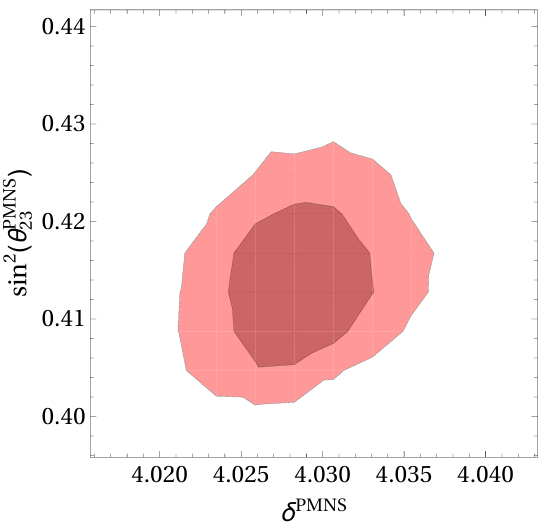
Figure 3 . Model prediction for the Dirac phase (cid:14) PMNS and sin 2 ( (cid:18) PMNS dark and the light red regions represent the 1 (cid:27) and the 2 (cid:27) HPD regions of the MCMC analysis,